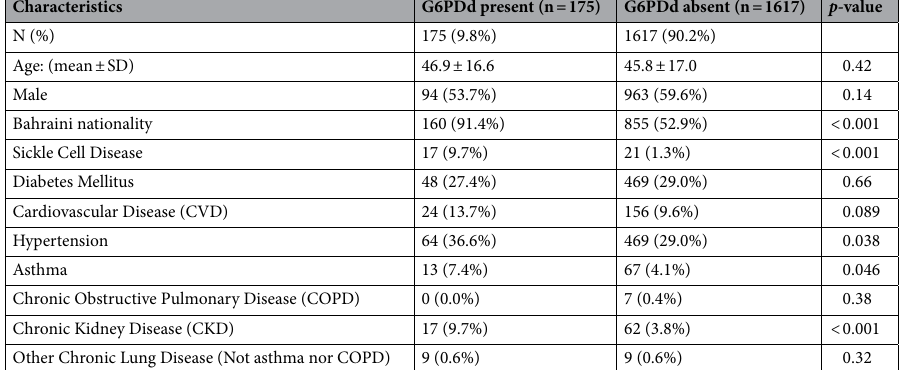
Table 1. Demographic characteristics and comorbidities in the study subjects.